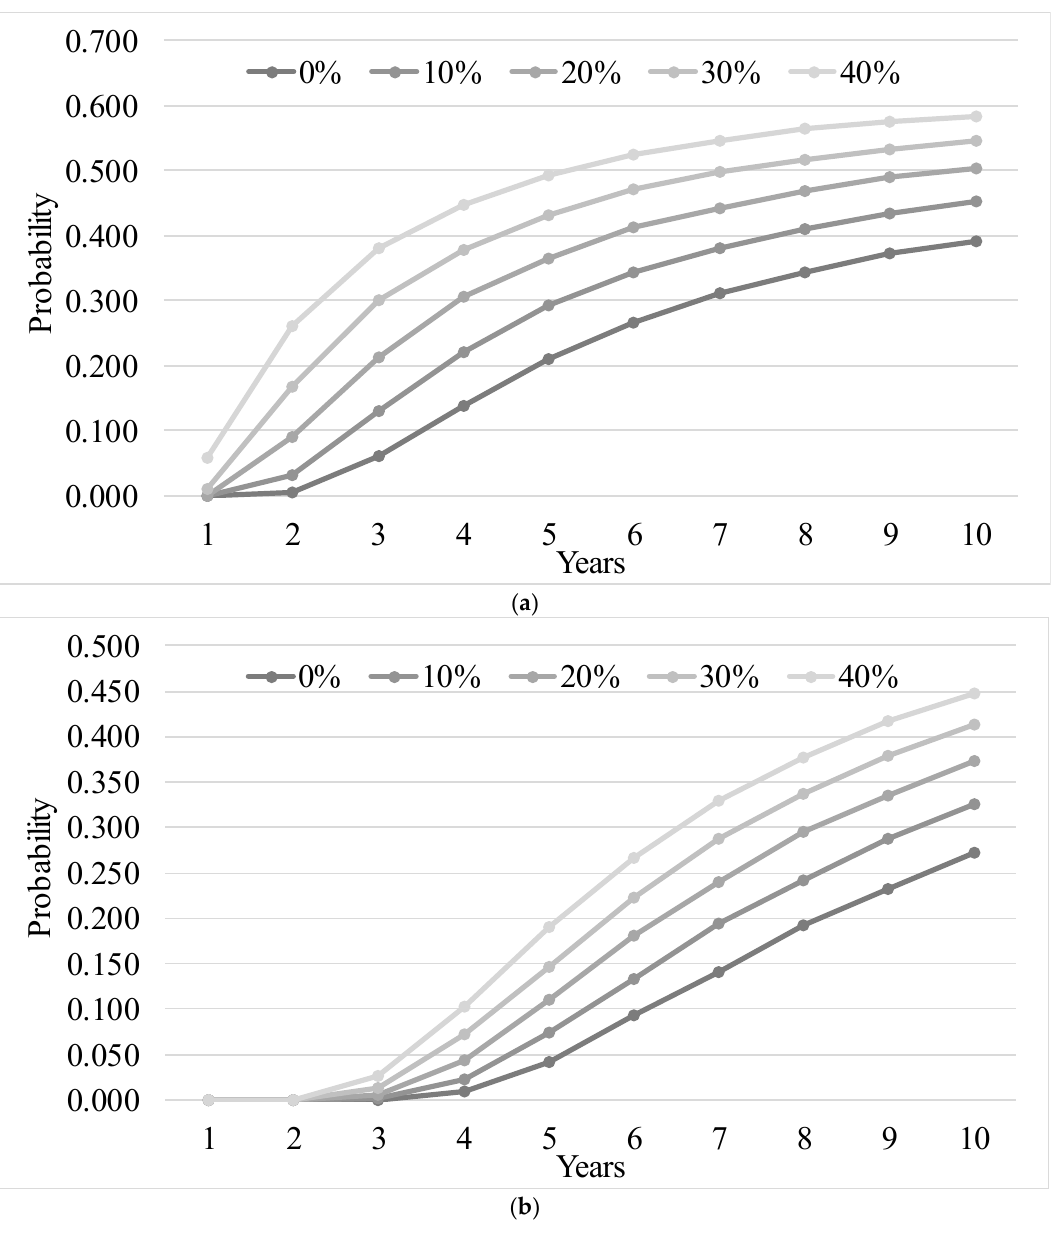
Figure 5. ( a ) Probability of farm debt to asset (D:A) ratio being greater than 50% under different starting debt levels (D:E Scheme 0. 20%, 30% and 40%) over the 10 year simulation period. ( b ) Probability of farm debt to asset (D:A) ratio being greater than 100% (point of insolvency) under different starting debt levels (D:E scenarios 0%, 10%, 20%, 30% and 40%) over the 10 year simulation period.